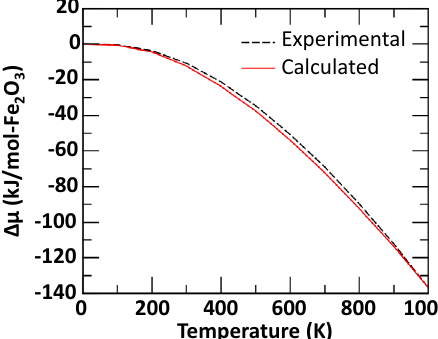
Fig. 2 Evolution of the chemical potential with temperature. Comparison between DFT + U calculated and experimental JANAF values of Δ μ ( T,P ) (in kJ/mol-Fe 2 O 3 ) for hematite ( α -Fe 2 O 3 ) at P = 1